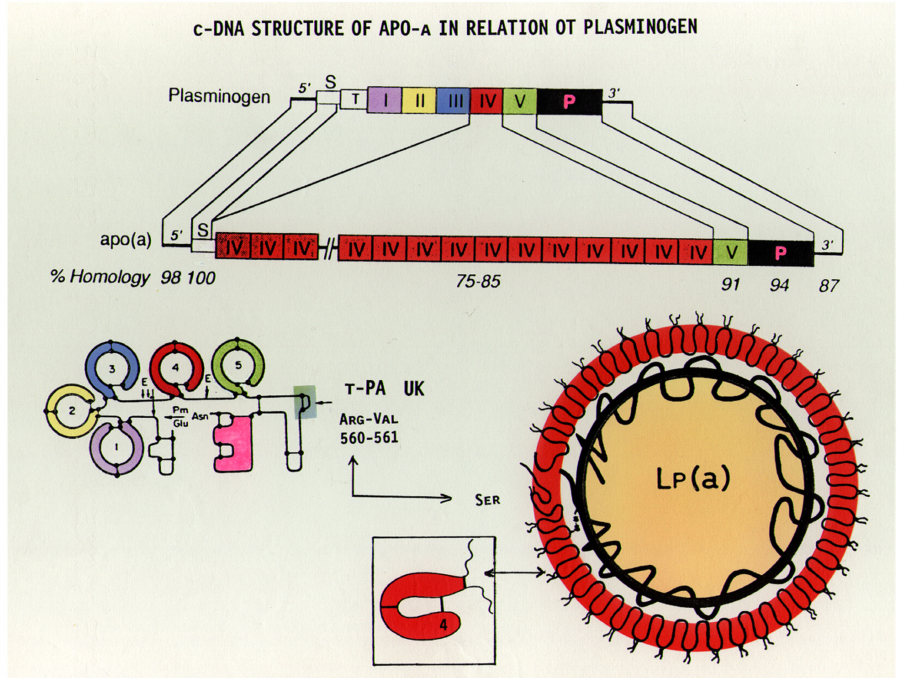
Figure 3. The cDNA structure of plasminogen in comparison to apo(a). While plasminogen has a single kringle-IV (K-IV) domain, a similar K-IV domain in apo(a) is repeated several times. Both structures possess a single K-V-like domain. In the protease domain of apo(a), the arginine of plasminogen is replaced by serine and therefore cannot be activated by t-PA or urokinase, as in the case of plasminogen [16].